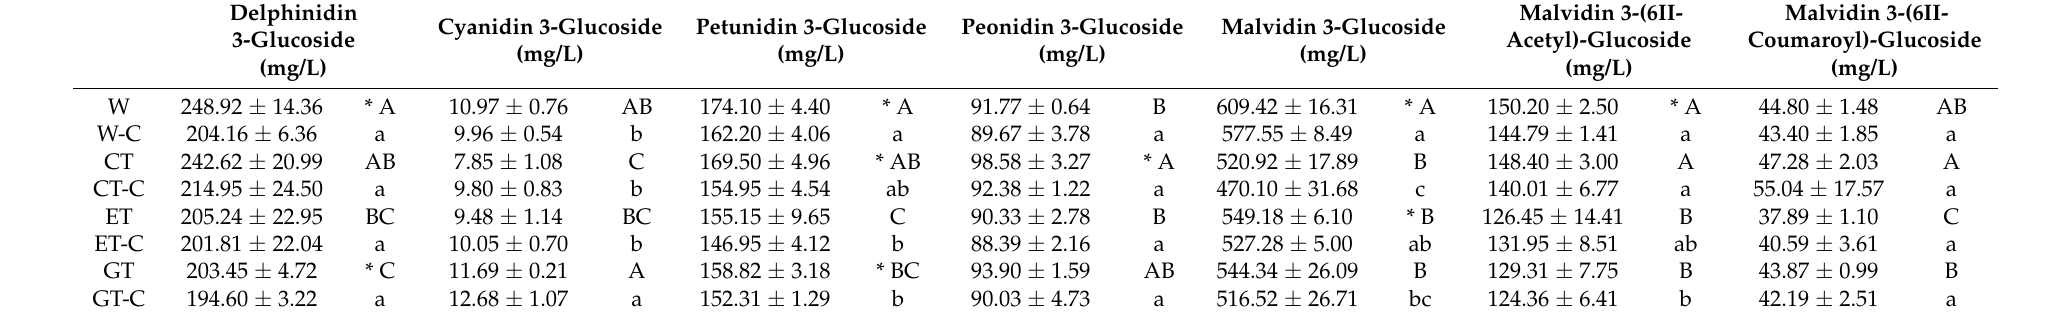
Table 2. Effect of tannins and C on native anthocyanins concentrations